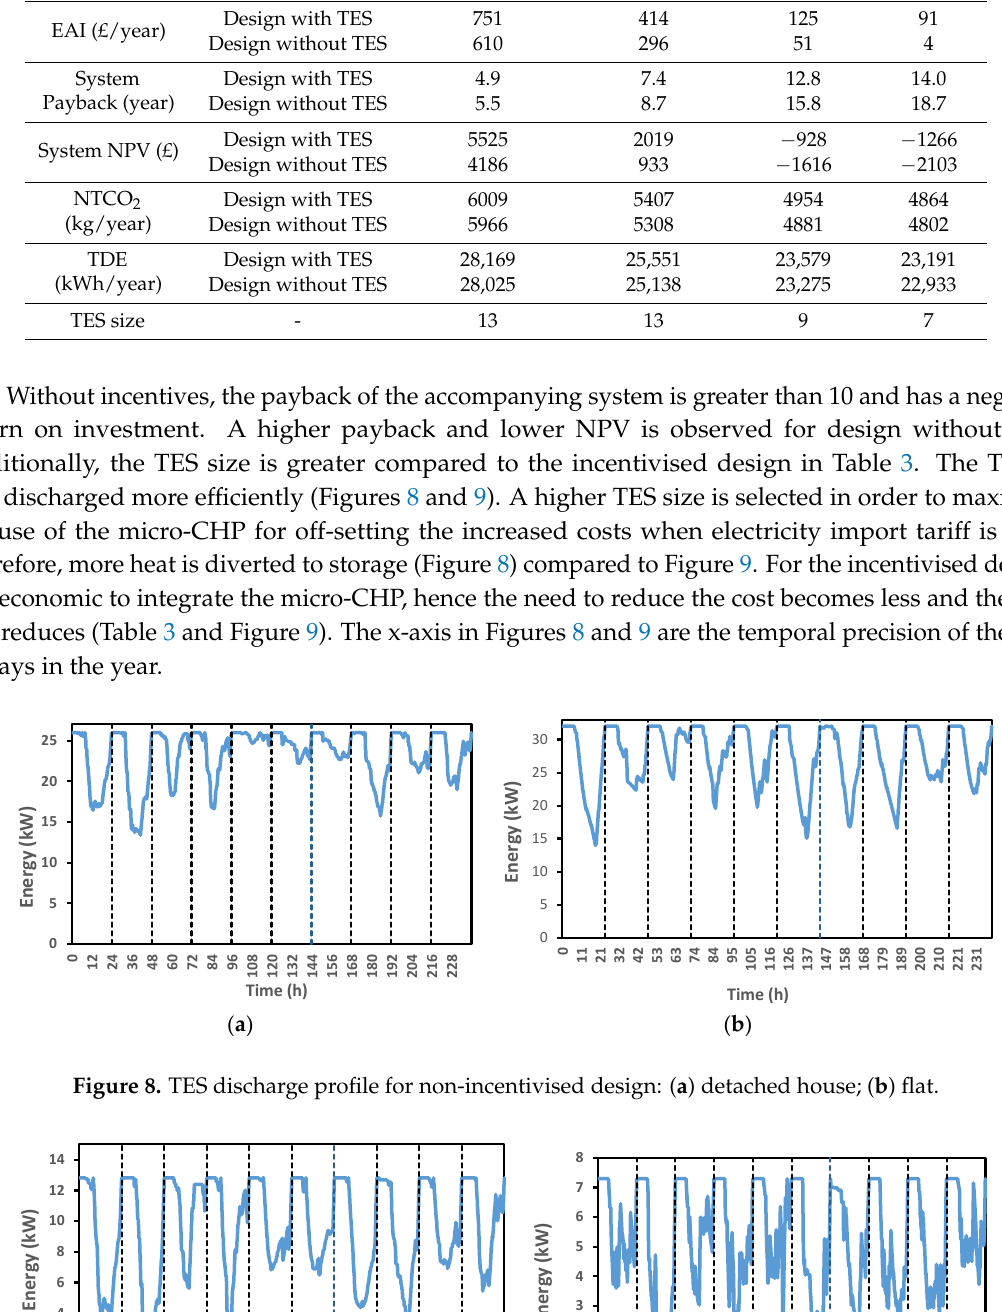
Table 3. Incentivised (FIT) design results.